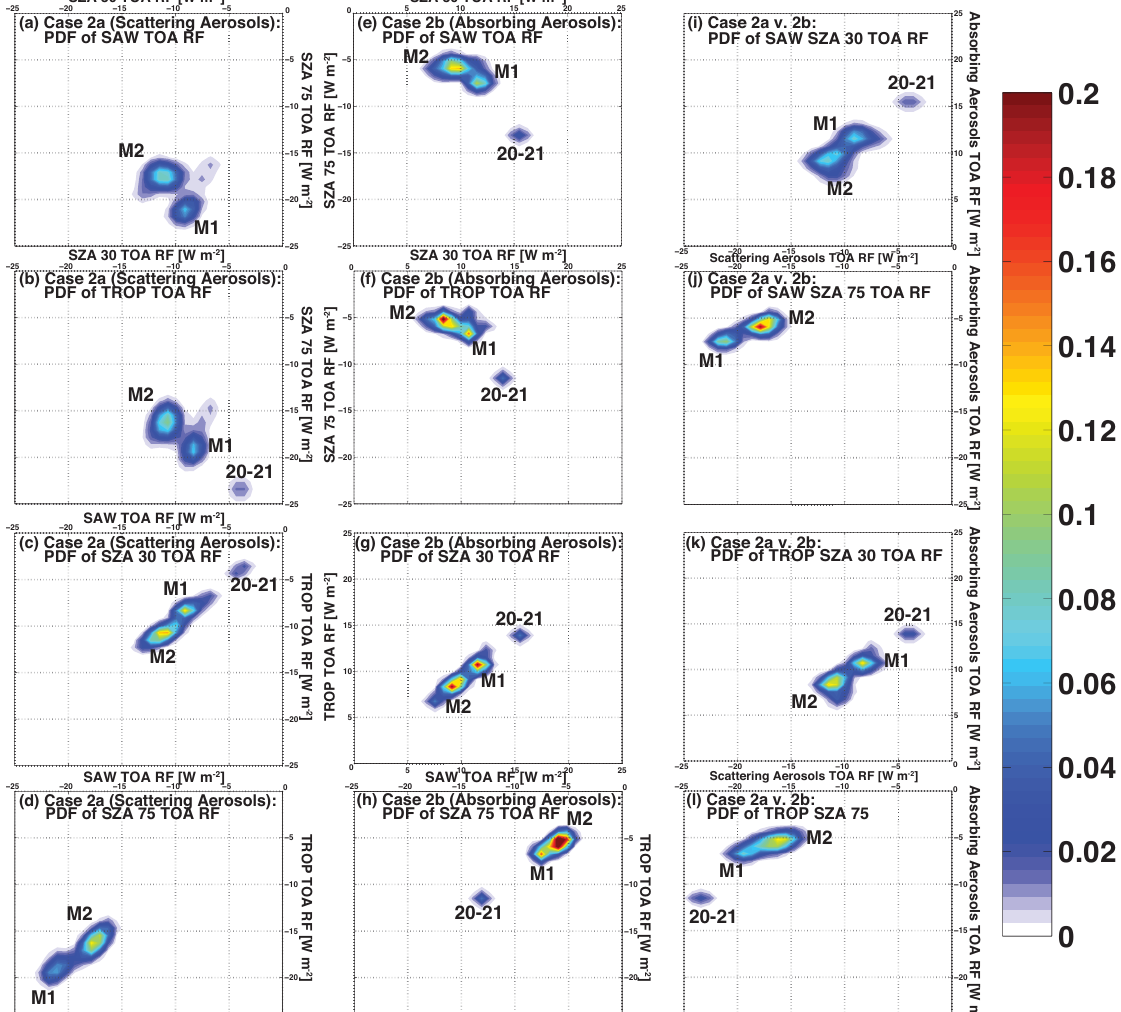
Fig. 6. Bi-variate probability density function (PDF) of TOA aerosol radiative forcing for Case 2a (Scattering Aerosols): (a) sub-Arctic winter as a function of solar zenith angle, (b) the tropics as a function of solar zenith angle, (c) SZA 30 ◦ as a function of prescribed atmosphere, and (d) SZA 75 ◦ as a function of prescribed atmosphere. PDFs of TOA RF for Case 2b (Absorbing Aerosols): (e) sub-Arctic winter as a function of solar zenith angle, (f) the tropics as a function of solar zenith angle, (g) SZA 30 ◦ as a function of prescribed atmosphere, and (h) SZA 75 ◦ as a function of prescribed atmosphere. PDFs of the effect of aerosol absorption (i.e. Case 2a vs. Case 2b) for given conditions: (i) SAW SZA 30 ◦ , (j) SAW SZA 75 ◦ , (k) TROP SZA 30 ◦ , and (l) TROP SZA 75 ◦ . The PDFs are calculated such that the volume is normalized to unity. Red shading indicates a large concentration of models. Group M1 includes Models #1–3, and 5–9. Group M2 includes most other models (except Models